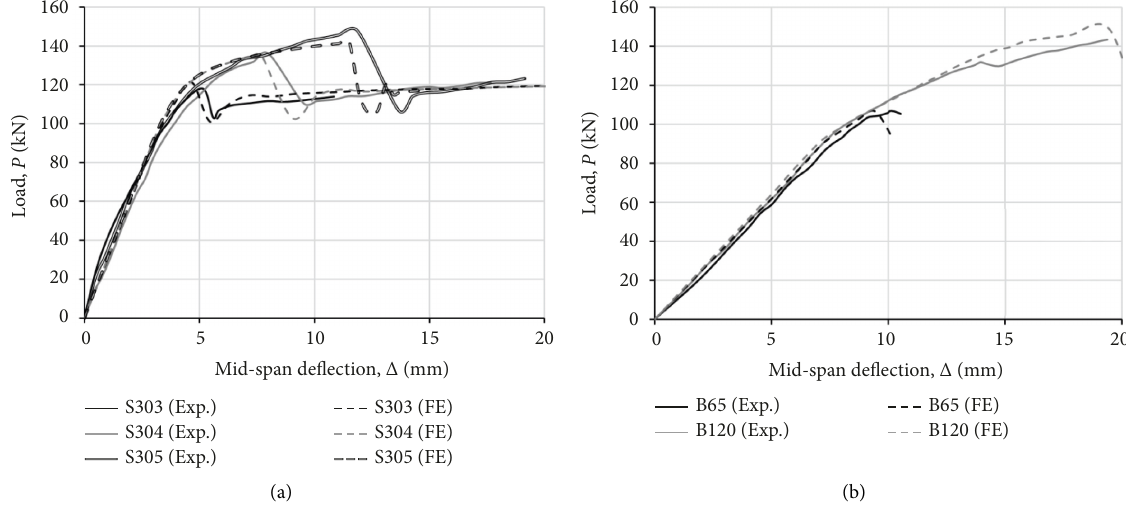
Figure 14: Load vs. mid-span deflection curves from FE models and experimental tests. (a) Deng et al. [27] and (b) Lenwari et al.